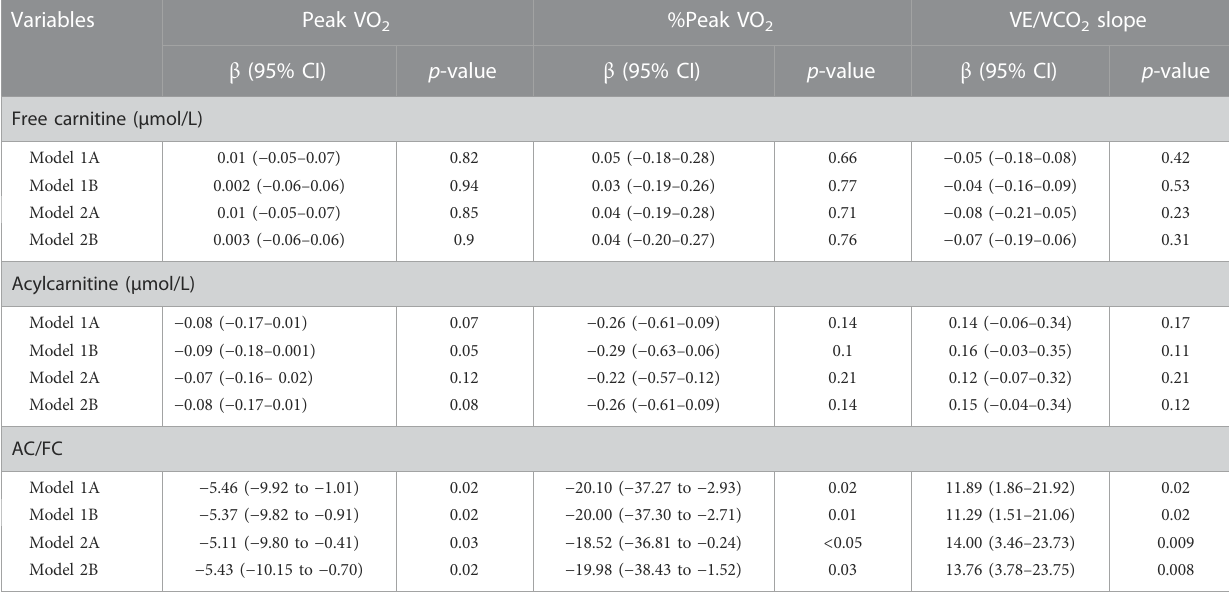
TABLE 6 Multiple linear regression analysis to determine the association of carnitine pro fi le with primary outcomes. Variables Peak VO